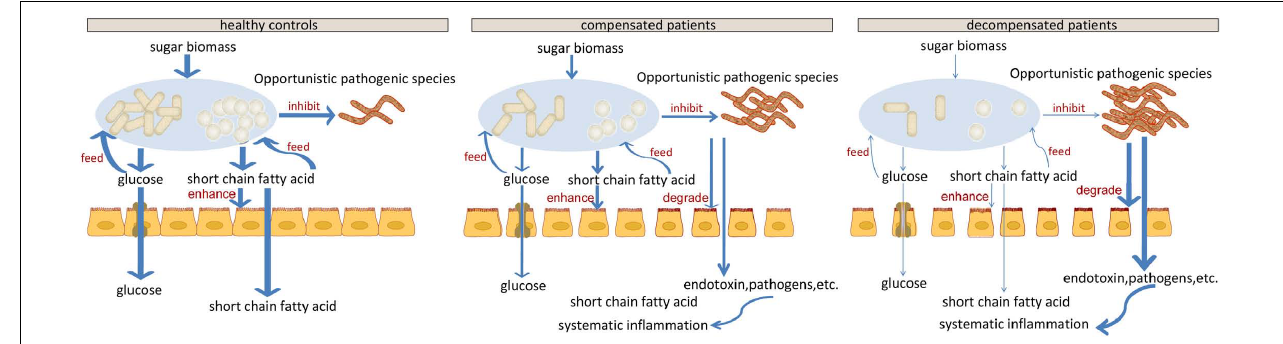
FIGURE 6 | Schematic diagram showing the potential roles of gut microbiota constituents during liver cirrhosis progression.